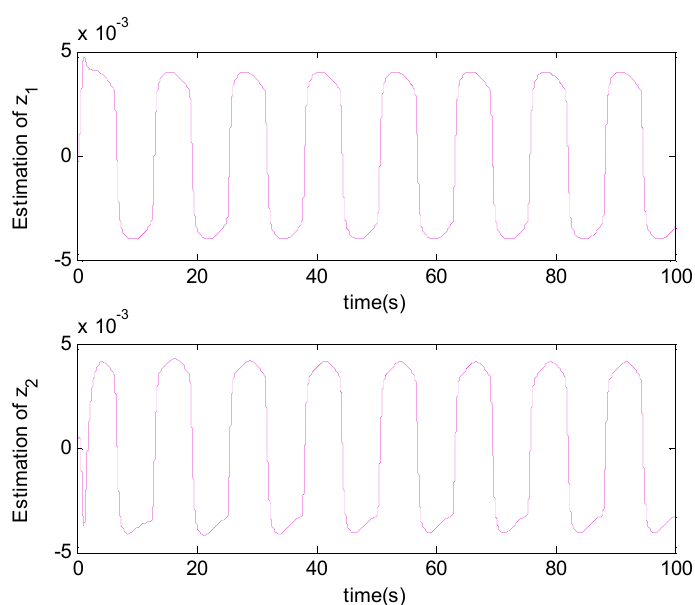
Figure 6. The parameter adaptation of ARCBF as ε = 1 × 10 − 6 .